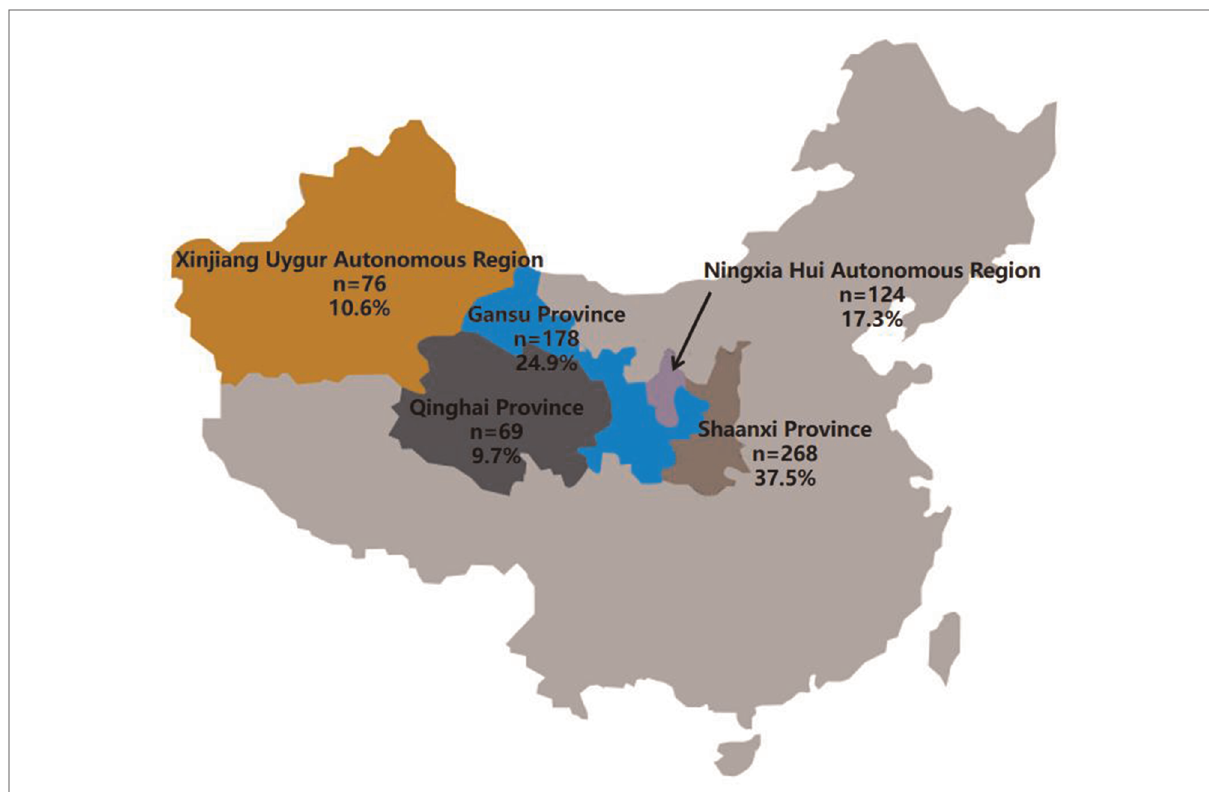
FIGURE 2 Geographical distribution of the total sample with a sample size of 715 collected from CBCT images of primary teeth and extracted primary